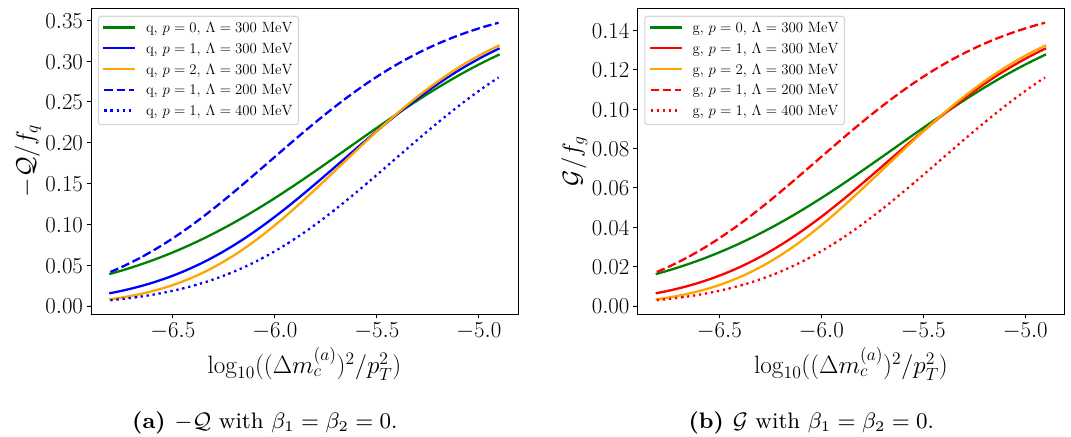
Figure 7. Pure quark (left) and gluon (right) observables with different shape function models included for the case with β 1 = β 2 = 0 . The parameters p and Λ of the shape functions are varied to show the sensitivity of the predicted values in the deep infrared region to the nonperturbative physics these shape functions